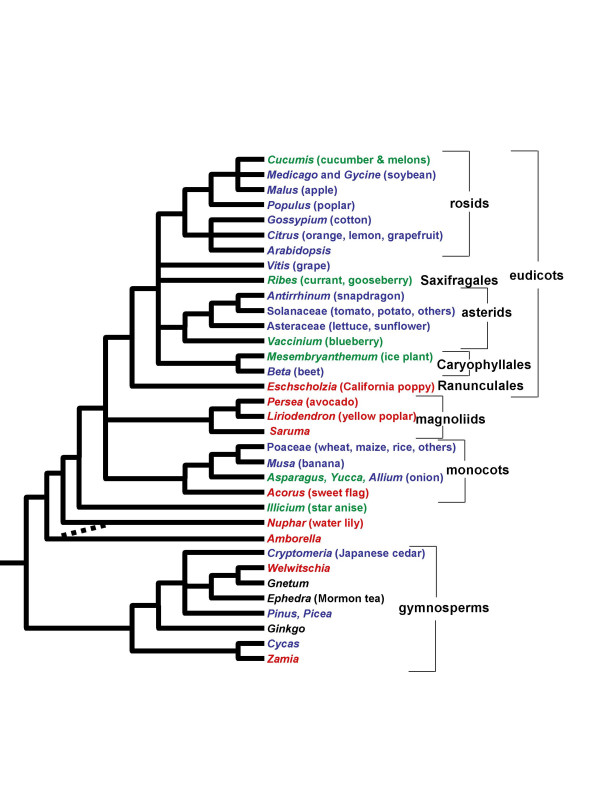
Well- supported evolutionary relationships among FGP species and other genomic models are shown in this phylogenic tree of seed plants. Red taxon names indicate those species for which we aim to sequence 10,000 ESTs, green taxon names indicate species for which we are sequencing 2000 ESTs, and blue taxon names indicate species for which large EST sets are already available in public databases [24, 25, 28, 29, 61] or will soon become available [70].